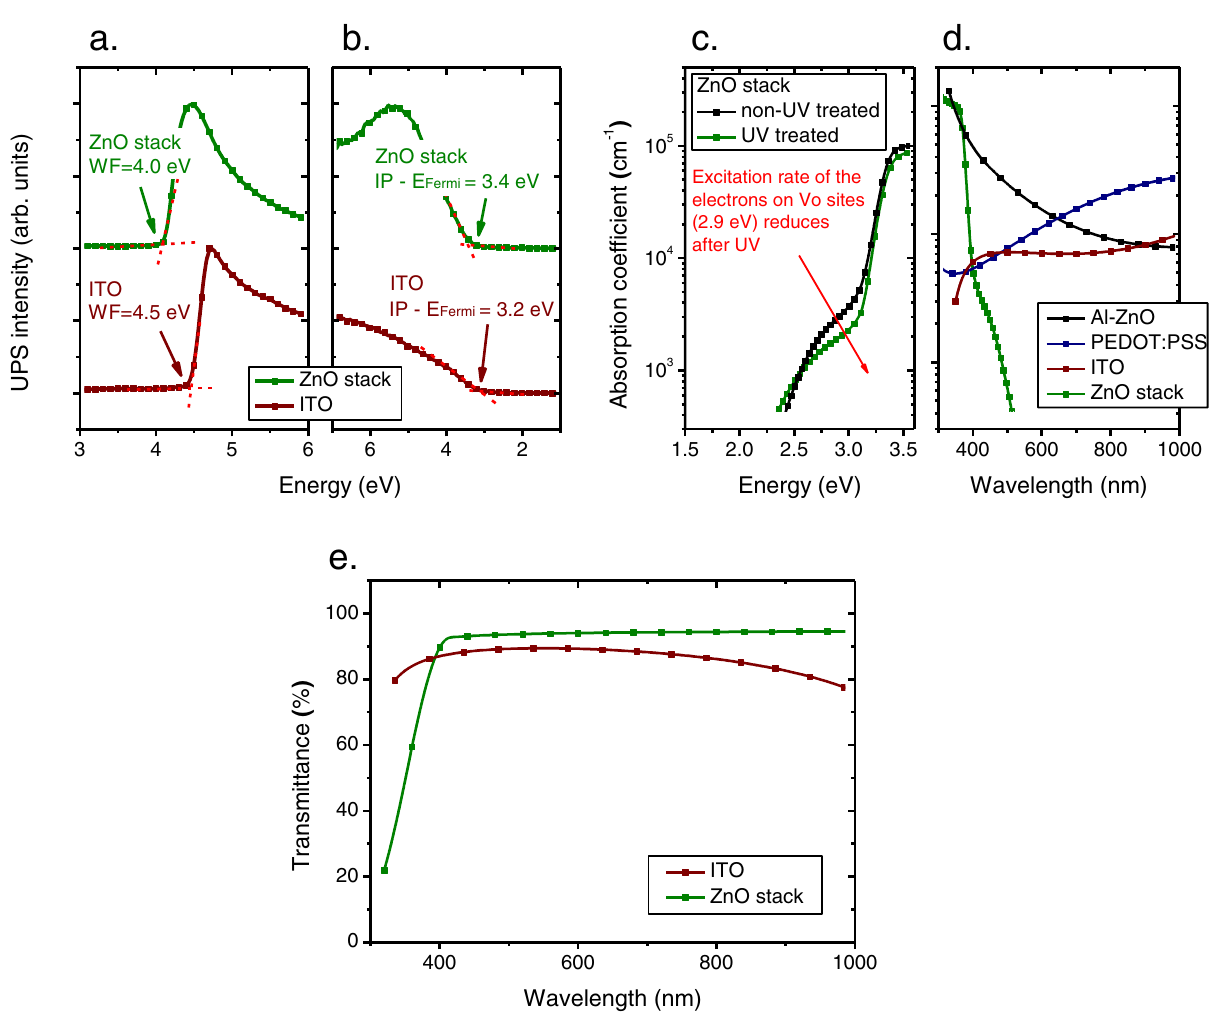
Fig.5|PhotoelectricalandopticalpropertiesoftheZnOstack.a Workfunction (WF) and b ionization potential of ITO and the ZnO stack with 6 layers of ZnO annealed at 320°C, deposited using the sequential deposition strategy. c Absorption coef fi cient of the ZnO stack before and after UV treatment (365nm,